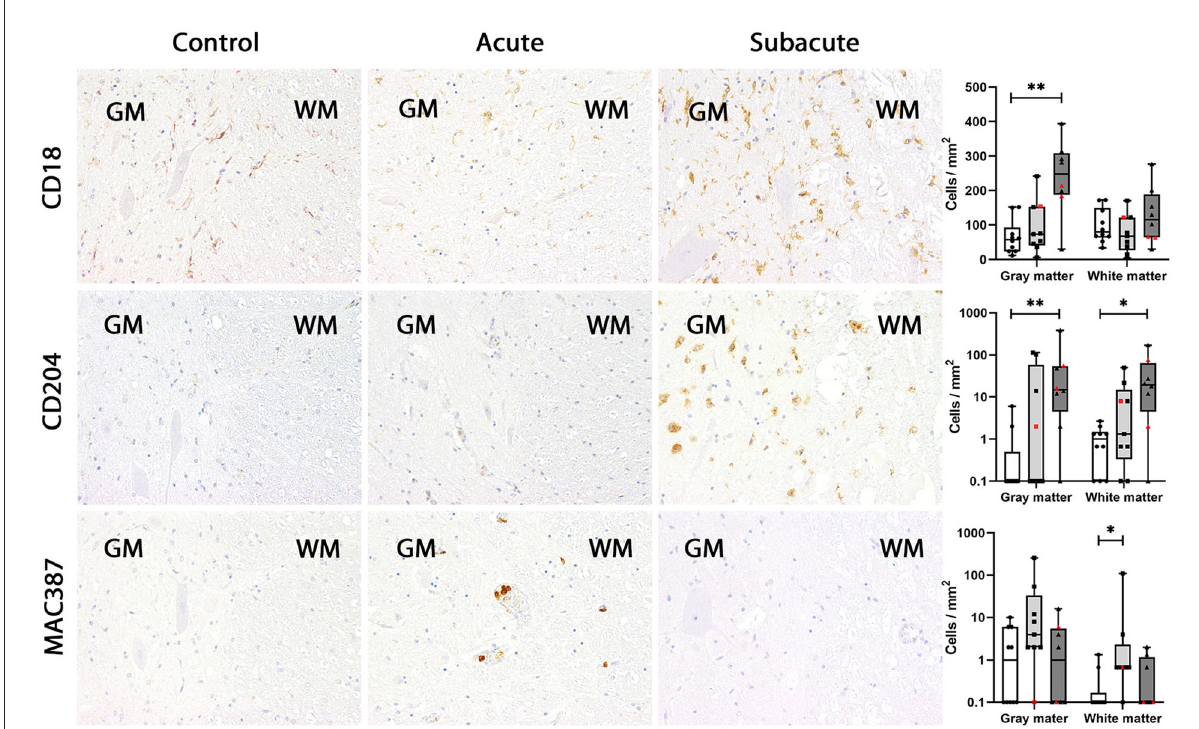
FIGURE2 CD18, CD204 and MAC387 expression in the canine spinal cord. In control dogs, a low number of microglia/macrophages expresses CD18 in gray and white matter. CD18 expression was not changed in dogs with acute spinal cord injury (SCI) but upregulated in the gray matter in subacute SCI. Expression of CD204 was almost absent in control dogs and in dogs with acute SCI. In dogs with subacute SCI, increased numbers of CD204-positive microglia/macrophages were found in gray and white matter. In control dogs, MAC387-positive cells were rarely detected. In dogs with acute SCI, a slight increase in the number of MAC387-positive cells was found, which was significant in the white matter. In contrast, MAC387-positive cells were nearly absent in dogs with subacute SCI. Immunohistochemistry using the avidin-biotin complex immunoperoxidase method. Shown are box plots with all data points (red: cervical SCI; black: thoracolumbar SCI). Kruskal-Wallis test: * p < 0.05; ** p <